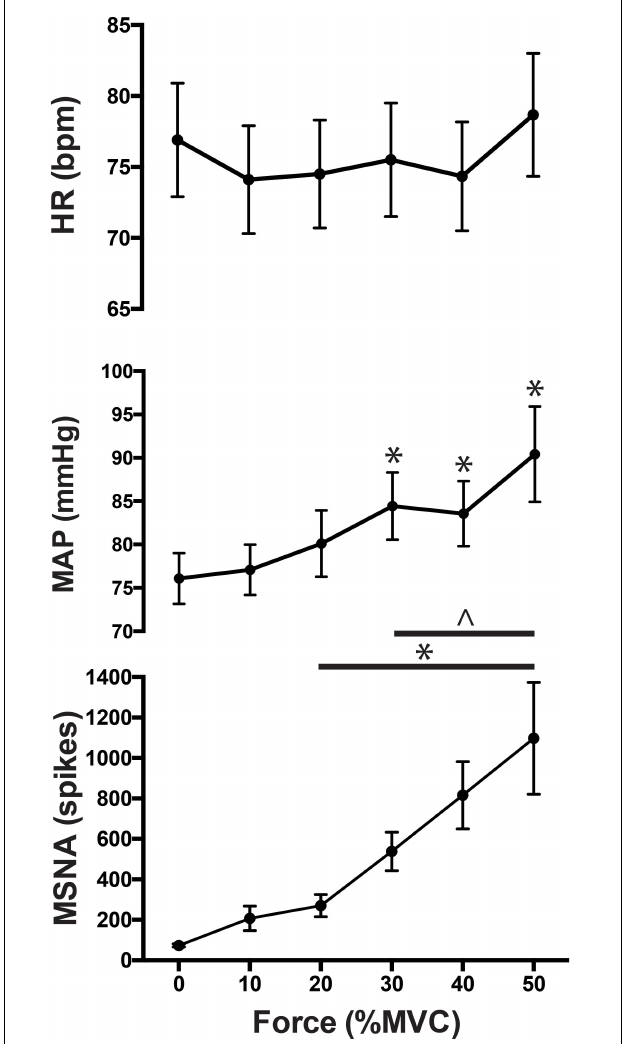
FIGURE 3 | MSNA (spikes/min), normalized mean arterial pressure (MAP) and heart rate responses to contractions at 0 (baseline), 10, 20, 30, 40, and 50% of maximal voluntary contraction (MVC). Main effects of time are indicated with an asterisk ( ∗ P < 0.05). Significant interactions are represented by ∧ ( P < 0.05).